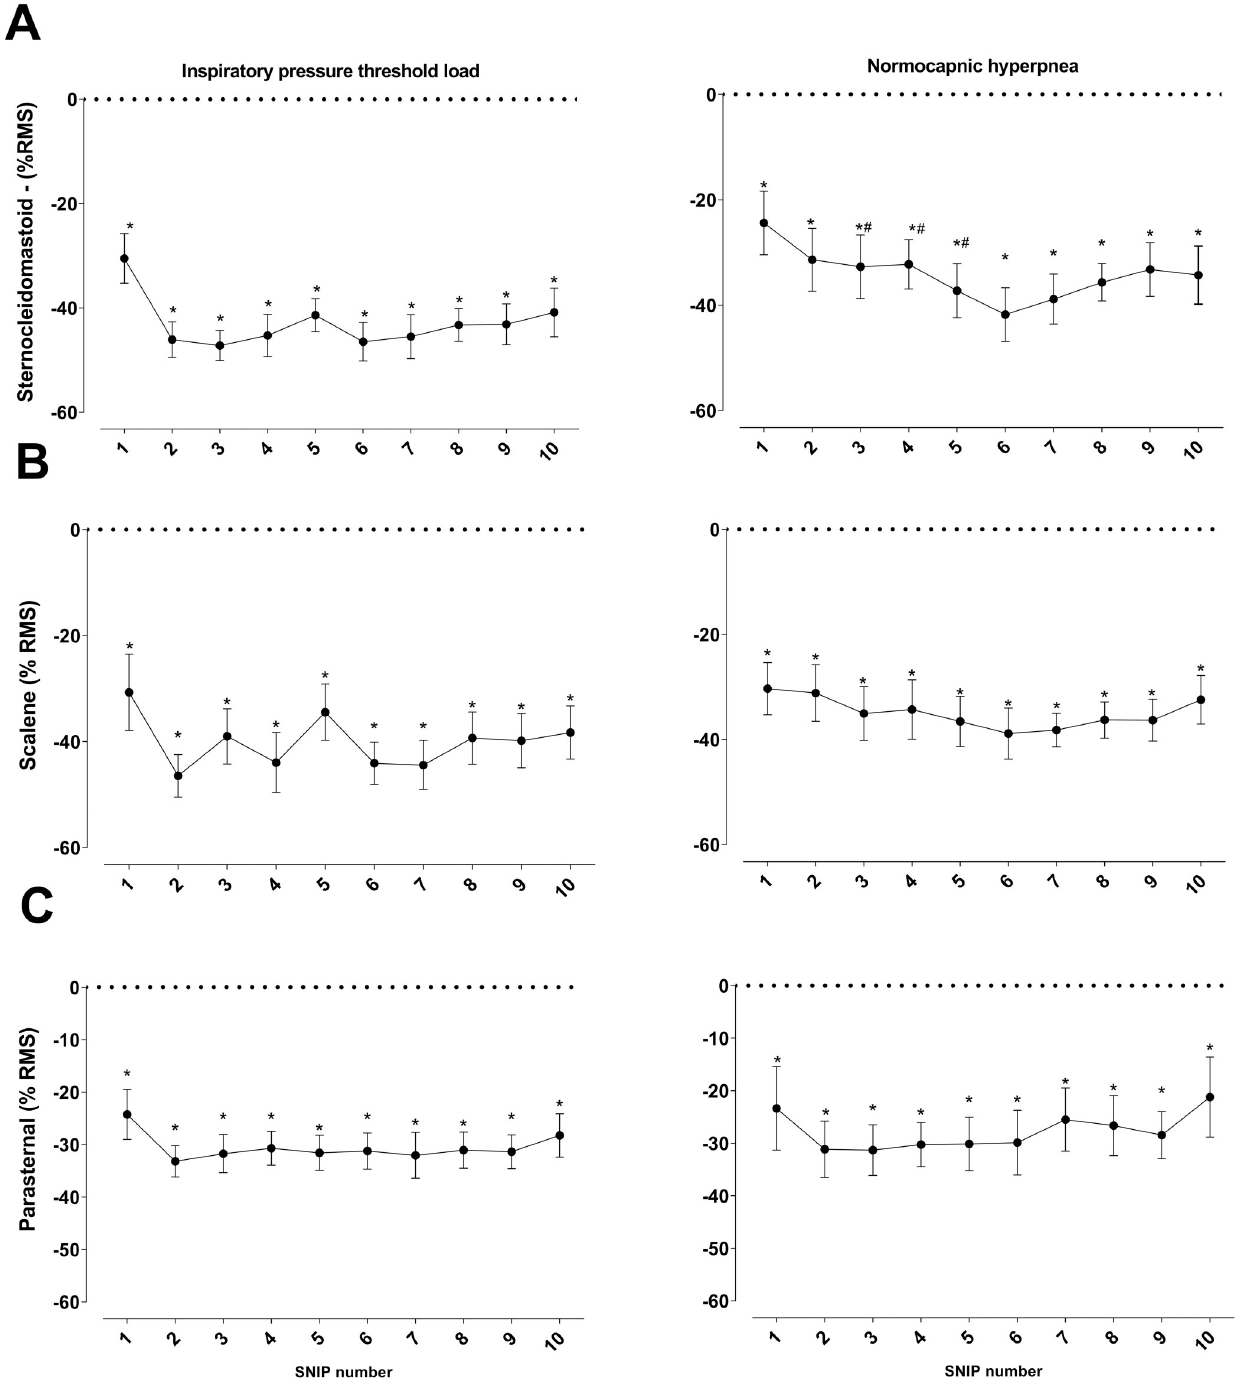
Fig 8. Changes in activation (RMS) of sternocleidomastoid (panel A), scalene (panel B), and parasternal muscles (panel C) compared with pre-test values. Data presented as mean ± SE. � p < 0.05 #: intergroup difference (p < 0.05).